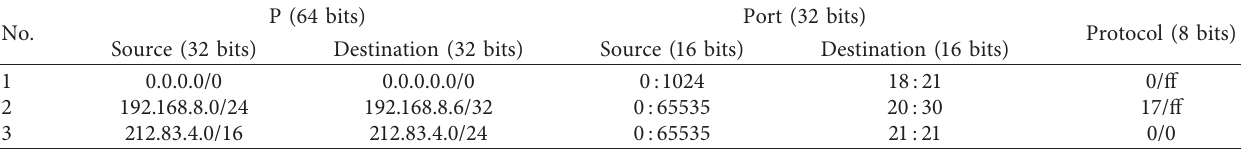
Table 1: A three-rule classifier.